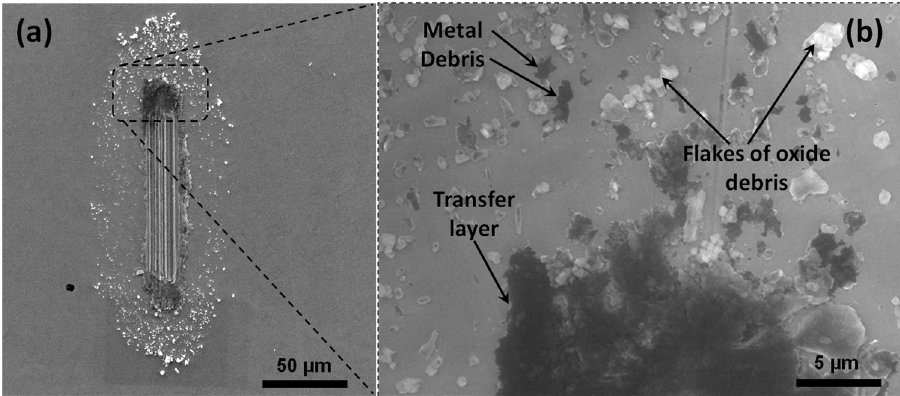
Figure 9. ( a ) Microscopic images of wear debris produced on EBM ‐ X in dry condition; ( b ) magnified image of the highlighted wear pile ‐ up.